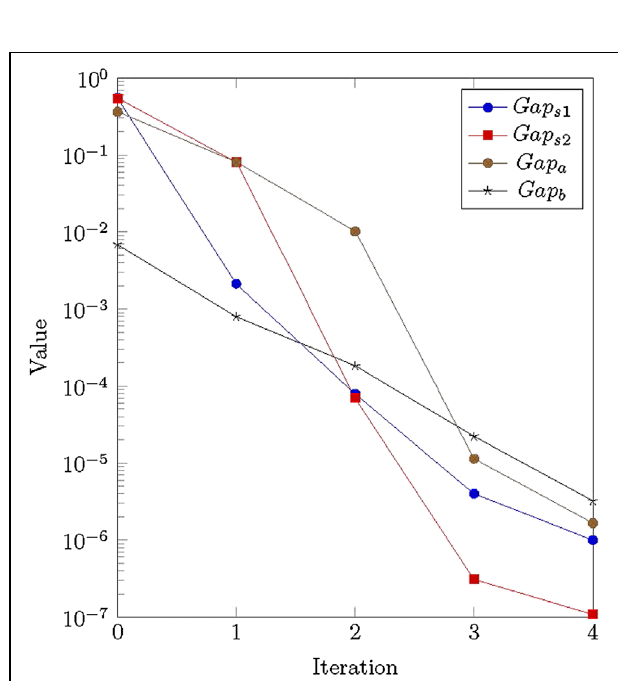
FIGURE 5 | Relaxation gap’s change during